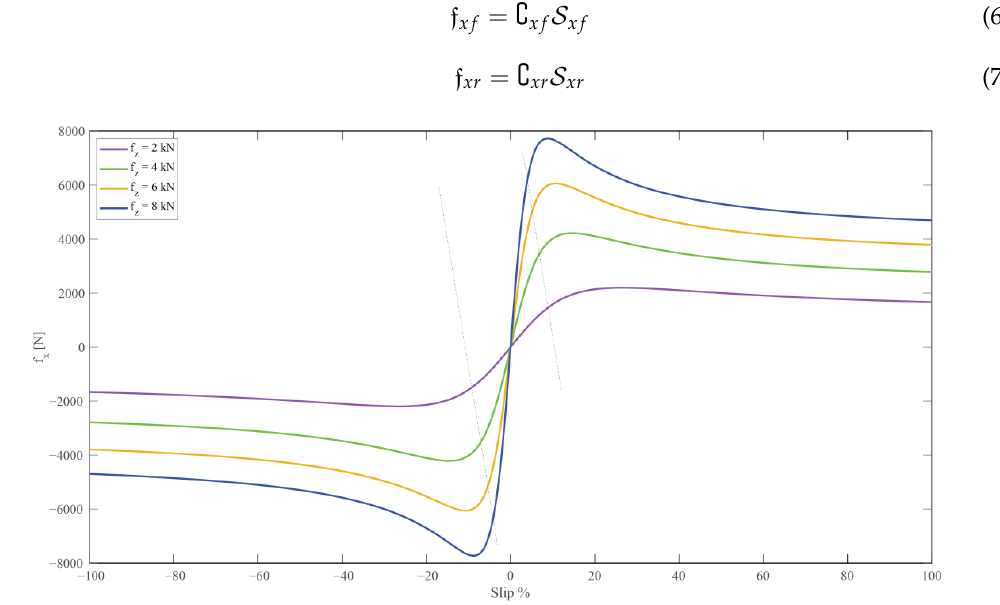
Figure 2. The vehicle ’ s longitudinal tire – road contact forces.